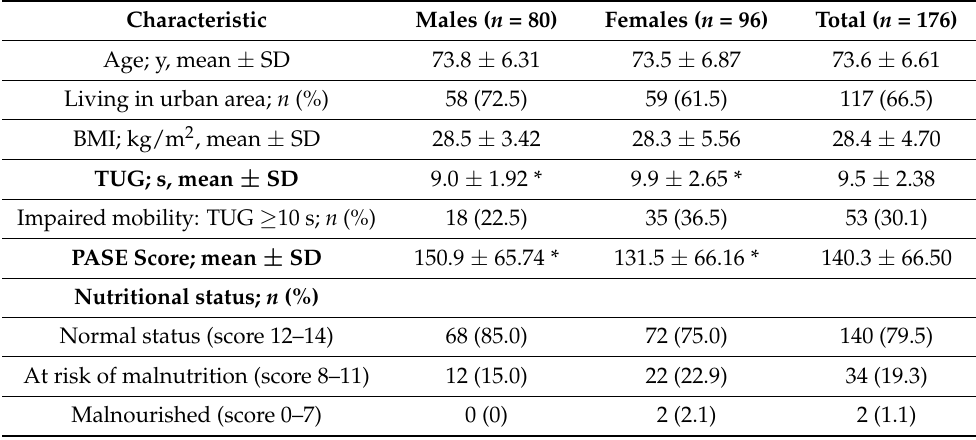
Table 1. Characteristics of study sample.